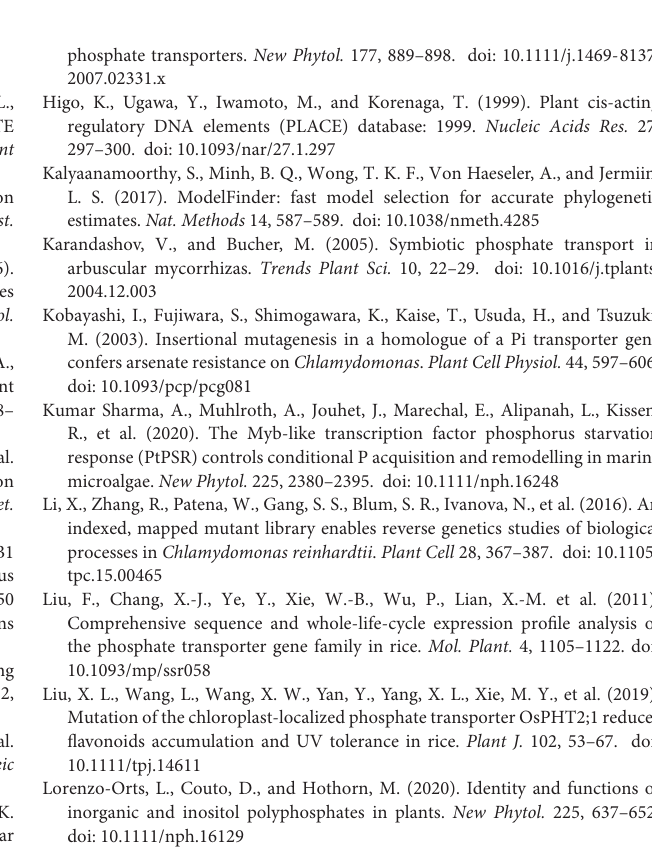
Supplementary Table 1 | List of gene duplication pairs identified in CrPHT genes. Supplementary Table 2 | Expression level of CrPHT genes under phosphate starvation in the WT and psr1 mutant. Supplementary Table 3 | List of all primers used in this